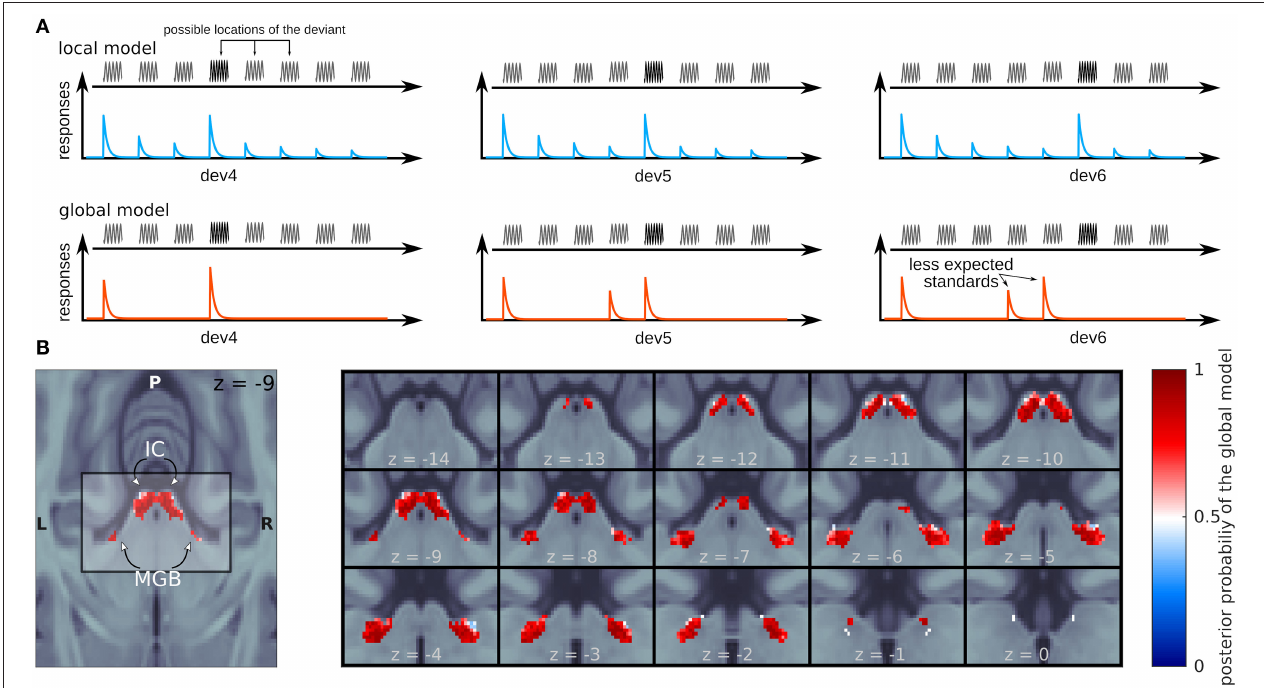
FIGURE 2 | Evidence for the global model in the human IC and MGB. (A) Schematic view of the expected responses for the different trials by the local (blue) and the global (red) models. (B) Posterior probability map of the global (red) and local (blue) models. z -coordinates correspond to the MNI